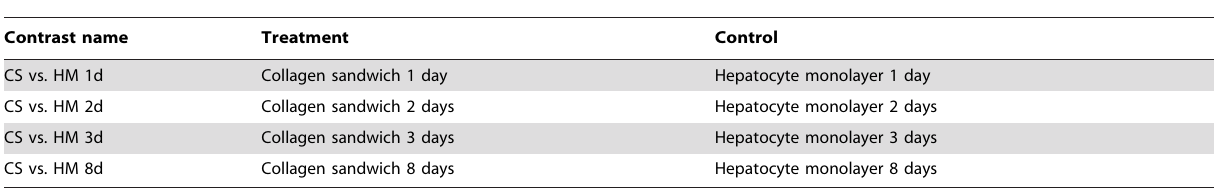
Table 1. Contrasts analyzed for contextual BPLNs.